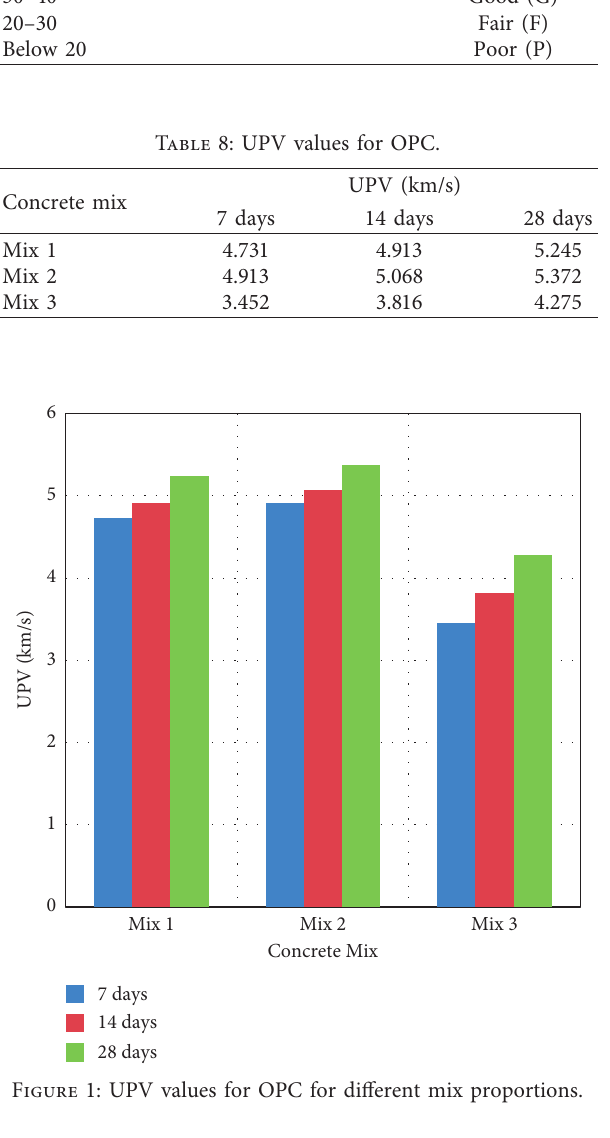
Figure 1 represents a plot between UPV values for OPC for different concrete mixes. And it was noticed that UPV values are increasing for increasing curing period. UPV values of Mix 3 are decreasing at all ages (7, 14, and 28 days). Table 9 represents UPV values for GPC concrete of all the three mix proportions after 7, 14, and 28 days of curing.